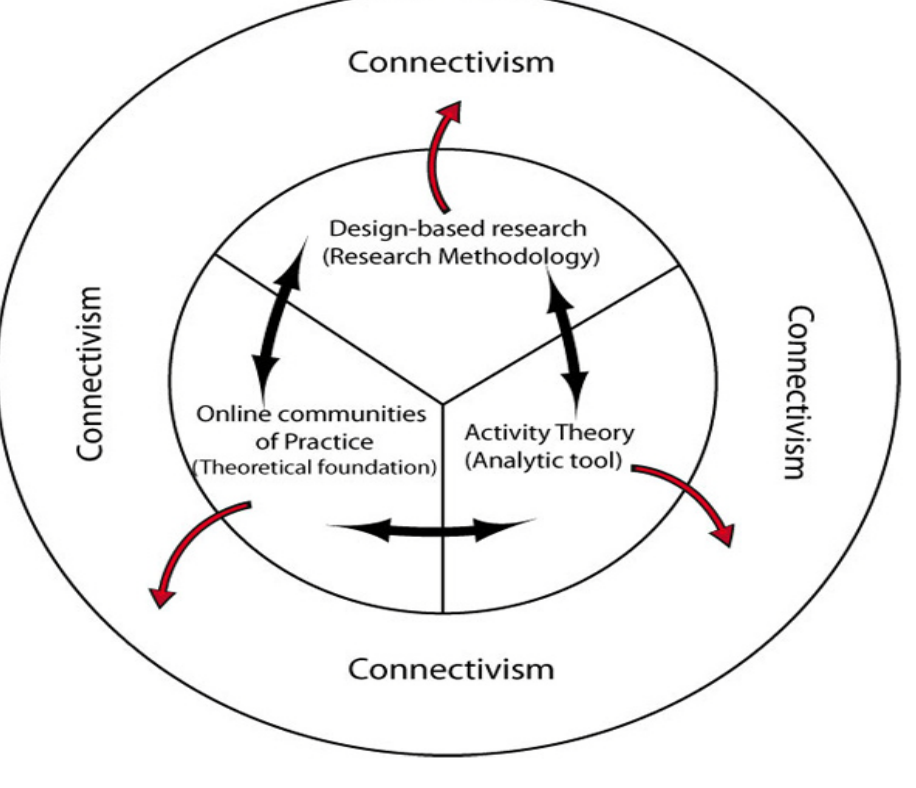
Figure 2 . A proposed framework of synergies for conducting developmental research in